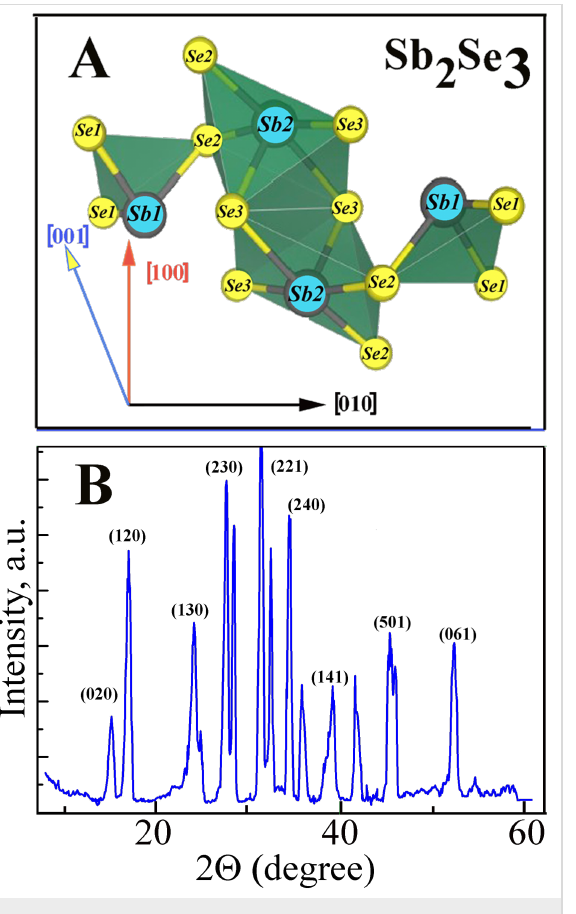
Figure 1: (A) Positions of the Sb and Se atoms in the Sb 2 Se 3 crystals. (B) The Sb 2 Se 3 crystalline XRD pattern.